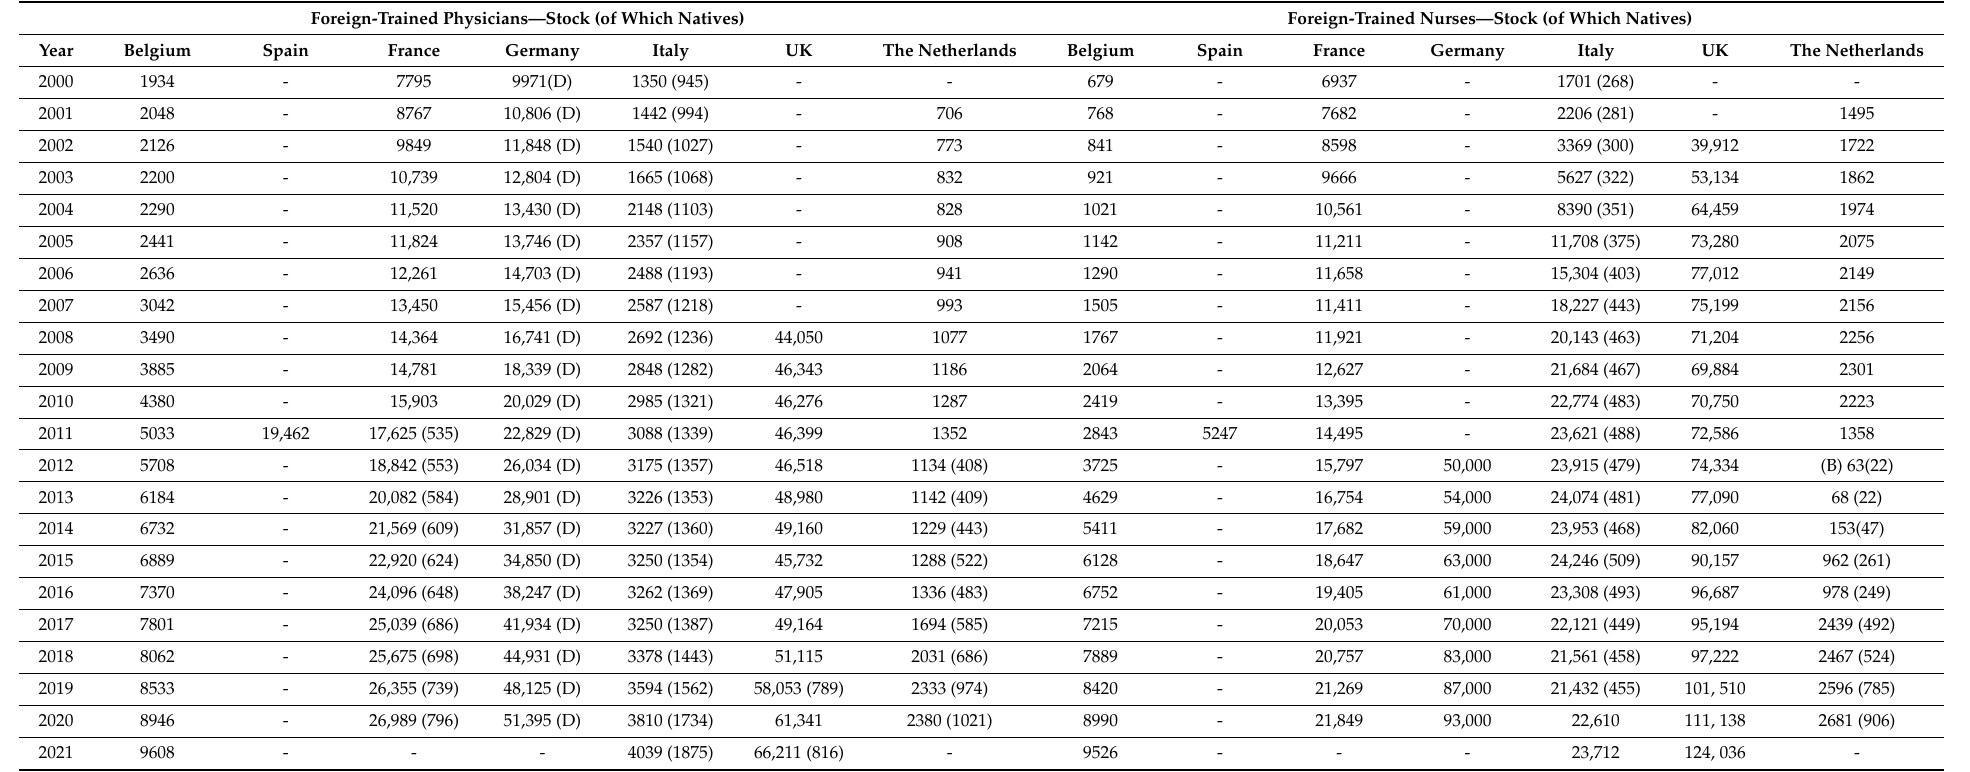
Table 1. Health workforce: physicians and nurses with foreign training from 2000–2021 (stock) in some European countries. Foreign-Trained Physicians—Stock (of Which Natives) Foreign-Trained Nurses—Stock (of Which